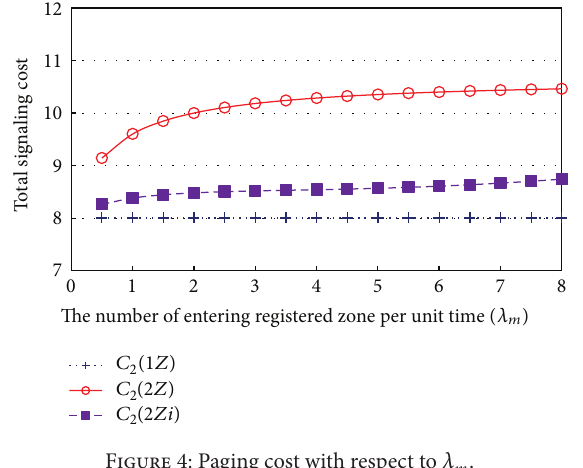
Figure 4: Paging cost with respect to 𝜆 𝑚 .